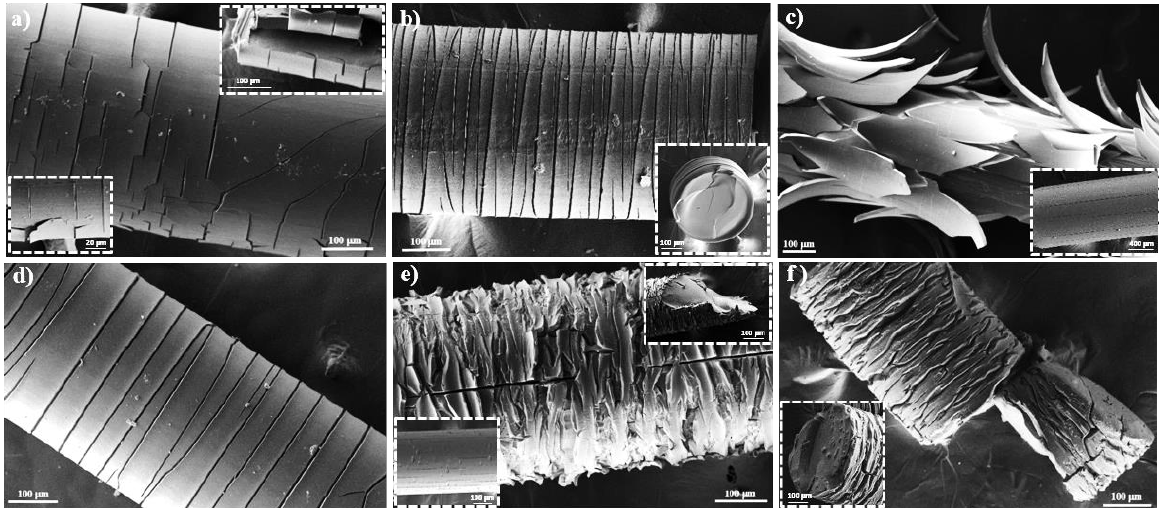
Figure 12. SEM micrographs showing the morphological changes of a γ irradiated GL- b -(GL- co -TMC- co -CL)- b -GL sample during exposure to: ( a ) a pH 4 medium for 35 days (inset 55 days); ( b ) a pH 4 medium for 88 days (inset cross-section detail); ( c ) a pH 7 medium for 35 days (inset 21 days); ( d ) a pH 7 medium for 88 days; ( e ) a pH 10 medium for 35 days (insets 21 days and cross-section detail at 35 days) and ( f ) a pH 10 medium for 88 days (inset cross-section